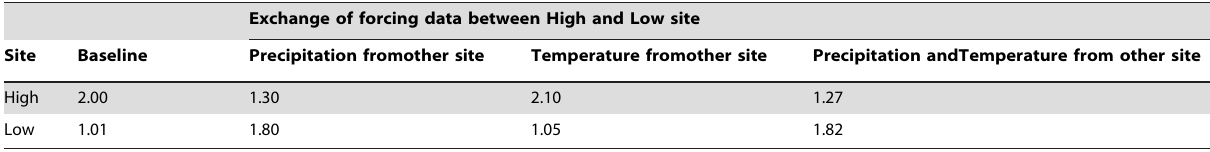
Table 3. Change in estimated NPP with climate forcing conditions.